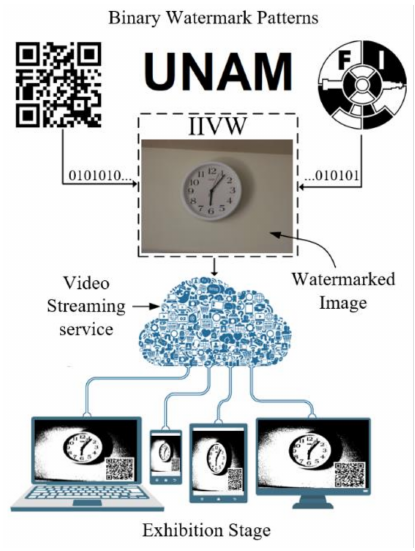
Figure 3. General diagram of the